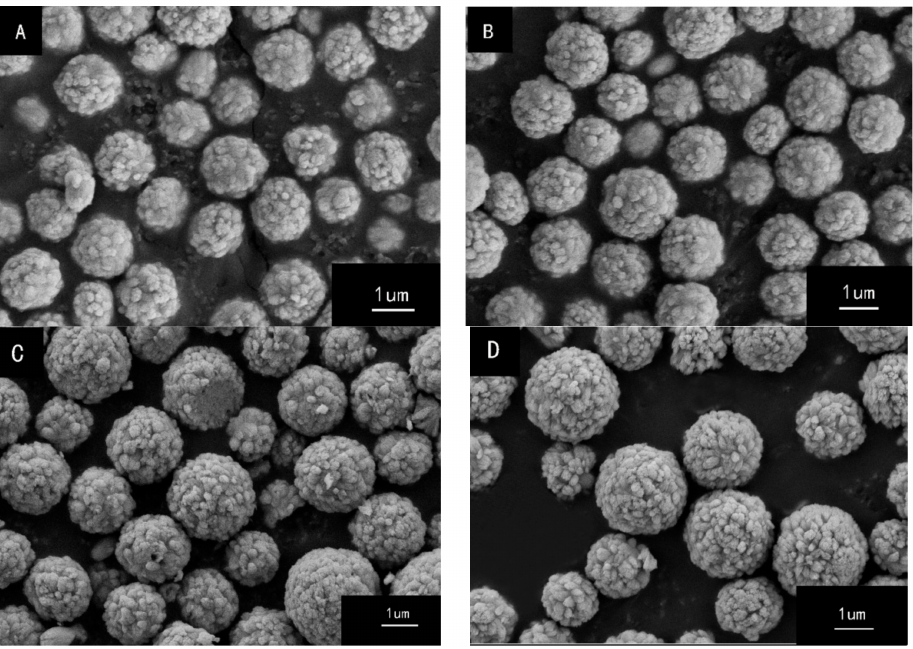
Figure 5. SEM of BaSO 4 at different Ostwald ripening times (( A ) 0, ( B ) 1 h, ( C ) 1 day, ( D ) 7